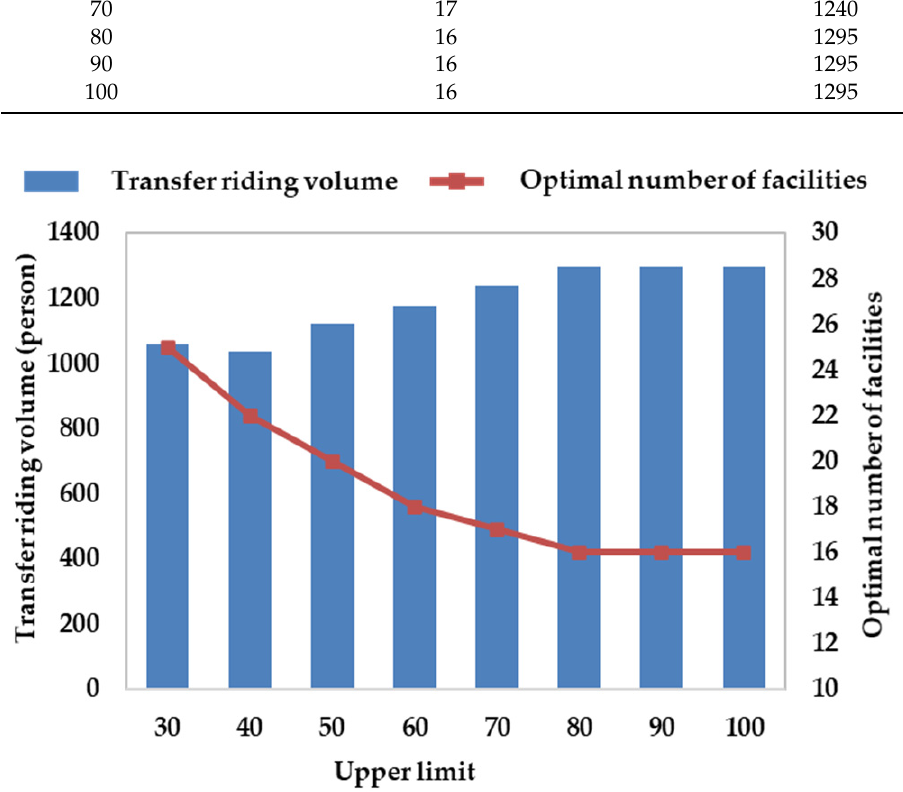
Figure 10. Sensitivity analysis of upper limit of bike-sharing allocation.